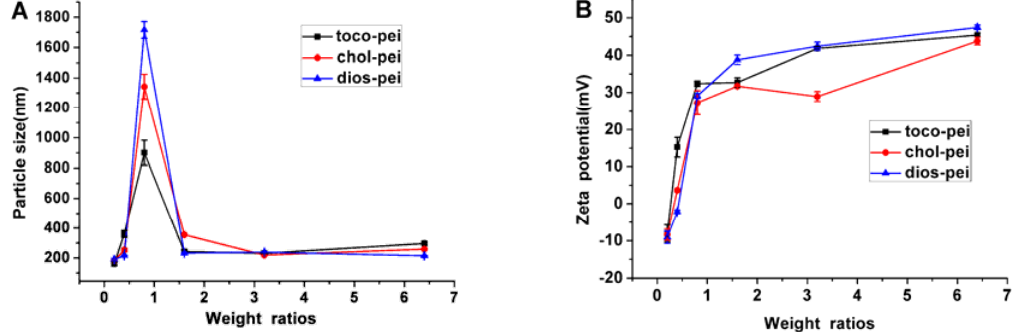
Figure 6. Average particle sizes ( A ) and average zeta potentials ( B ) of lipopolymer/DNA polyplexes at w / w concentrations of 0.2, 0.4, 0.8, 1.6, 3.2, and 6.4 (mean ± SD, n = 3).